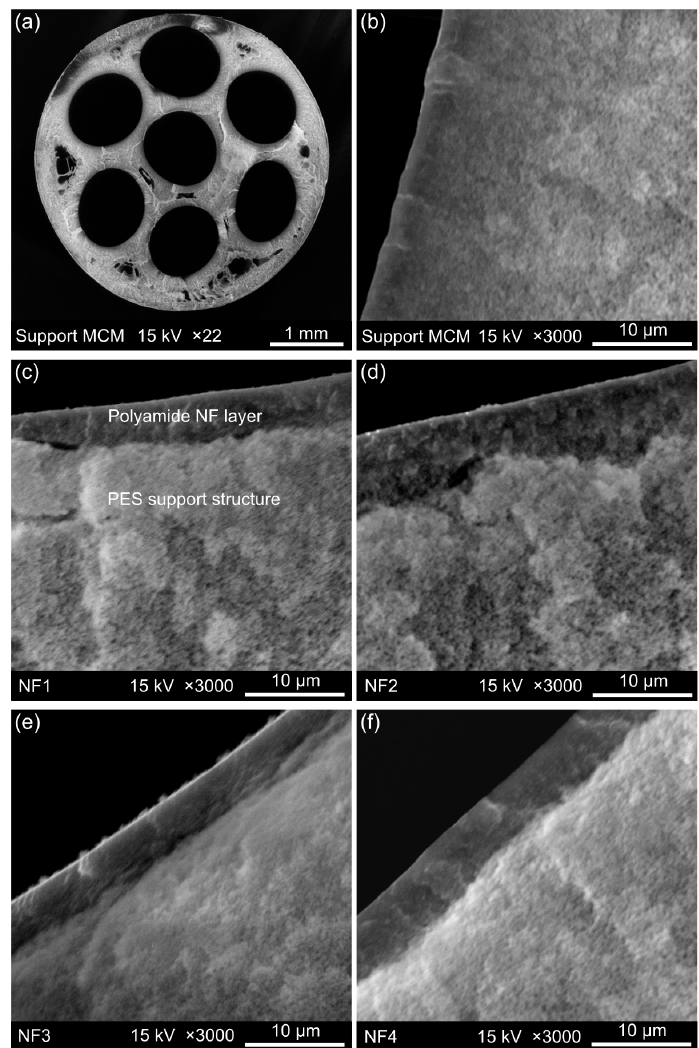
Figure 6. Cross sectional scanning electron microscope (SEM) images of ( a ) support MCM; ( b